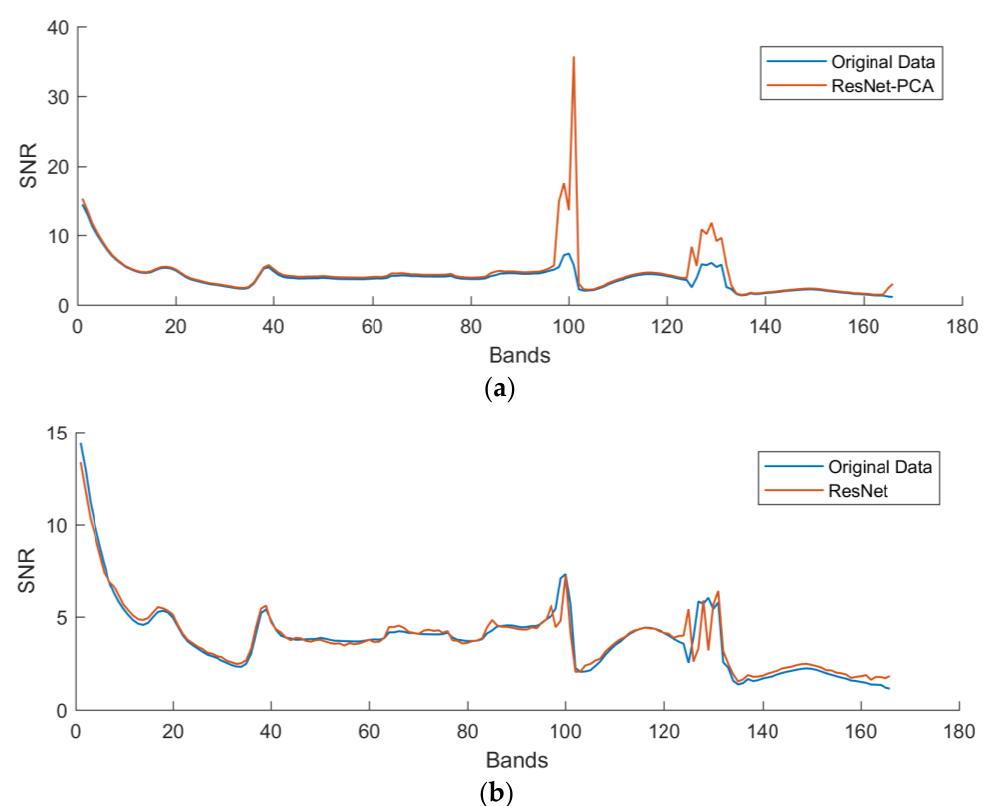
Figure 6. SNR comparison between SRE-ResNet and ResNet for Dataset I. ( a ) SRE-ResNet, ( b ) ResNet.